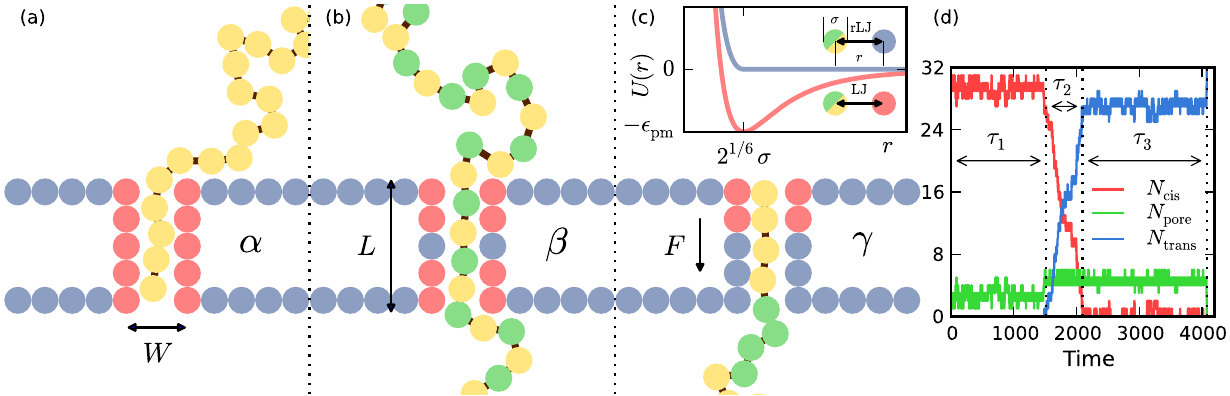
FIG. 1. The schematics of the polymer and nanopore models. Simulation snapshots showing the translocation of a homopolymer and heteropolymers with different block lengths across the three patterned pores at various stages of the translocation process, namely, filling, transfer, and escape. (a) A homopolymer (yellow) translocating from the cis to the trans side of Pore (cid:2) . The interaction of the pore monomers (red) with the polymer has an attractive well whereas the monomers that make up the walls of the pore (blue) have an excluded volume interaction with the polymer. The pore width is fixed and there is a constant force driving the polymer that acts inside the pore. (b) A heteropolymer (poly ð dAdC Þ 16 ) of block length M ¼ 2 with alternating bases A (yellow) and C (green) translocating across Pore (cid:3) . Pore (cid:3) consists of two sticky monomers on either end of the pore that are separated by a wall monomer. The bases A and C have different interactions with the sticky monomers. (c) A heteropolymer (poly ð dA 4 dC 4 Þ 4 ) of block length M ¼ 8 translocating across Pore (cid:4) , which has two sticky monomers on the cis side and three repulsive monomers on the trans side that result in an attractive entrance and a repulsive exit. (Inset) Shows the pore-polymer potentials. (d) A trace of the monomer count at the trans end, middle, and cis end of the pore as functions of time for a homopolymer translocating through Pore (cid:4) , with (cid:1) pm ¼ 3 and F ¼ 0 : 5 . (cid:6) (cid:6) (cid:6) 1 , 2 , and 3 change dramatically when pore patterning is